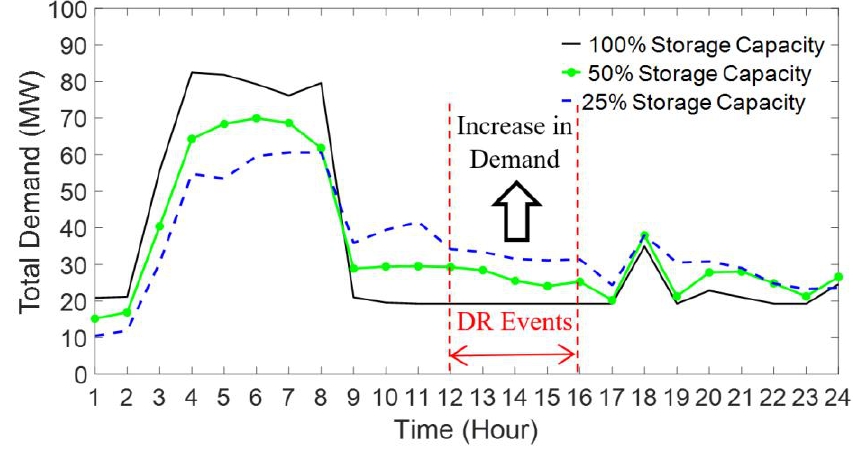
Figure 15. Role of storage in peak shaving.